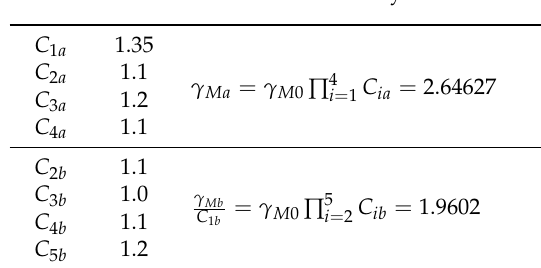
Table 4. Calculation of the safety